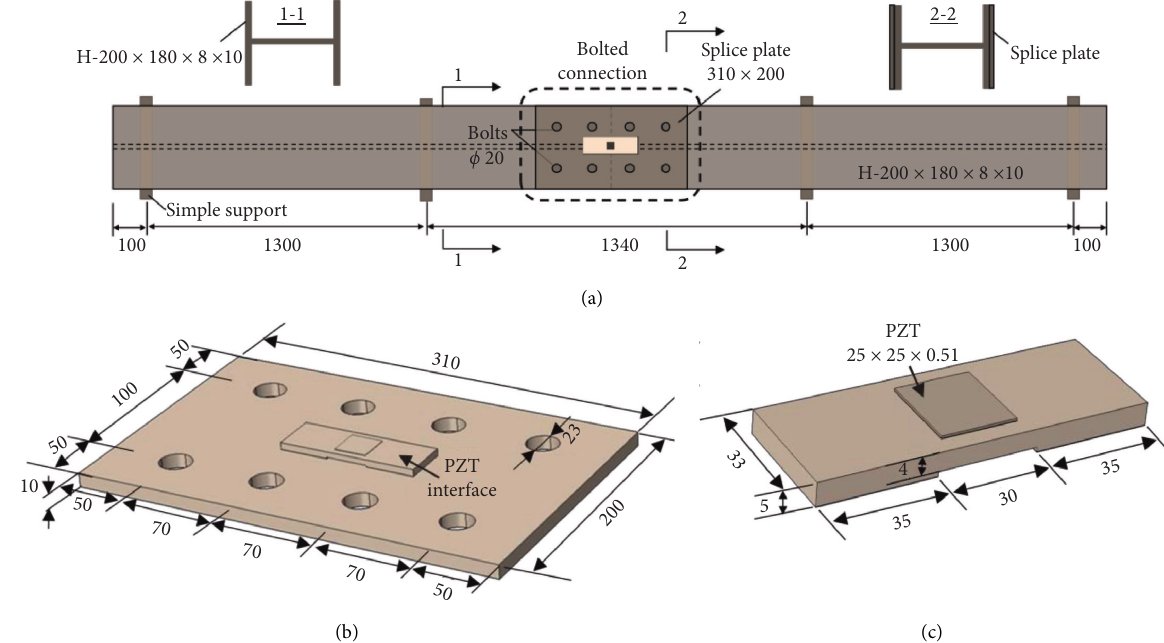
Figure 5: Geometric dimensions (mm) of the experimental model. (a) Steel girder. (b) Connection splice. (c) Smart interface.